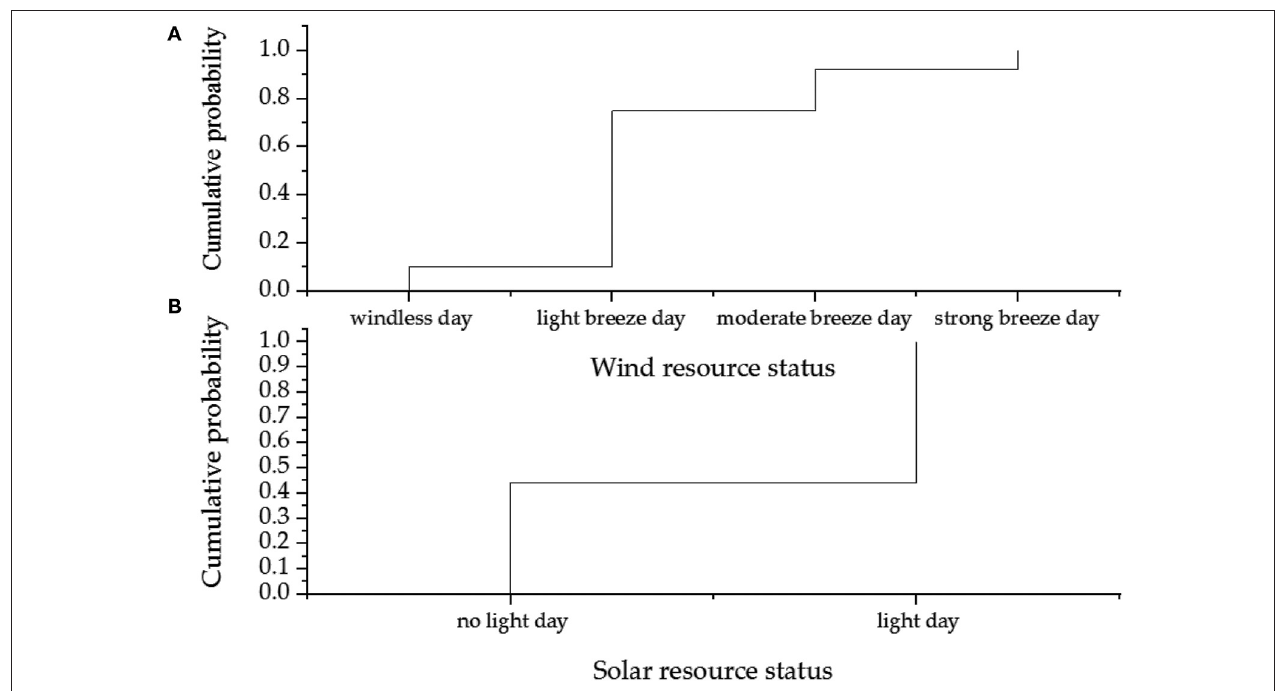
FIGURE 6 | Cumulative probability distribution map of wind and solar